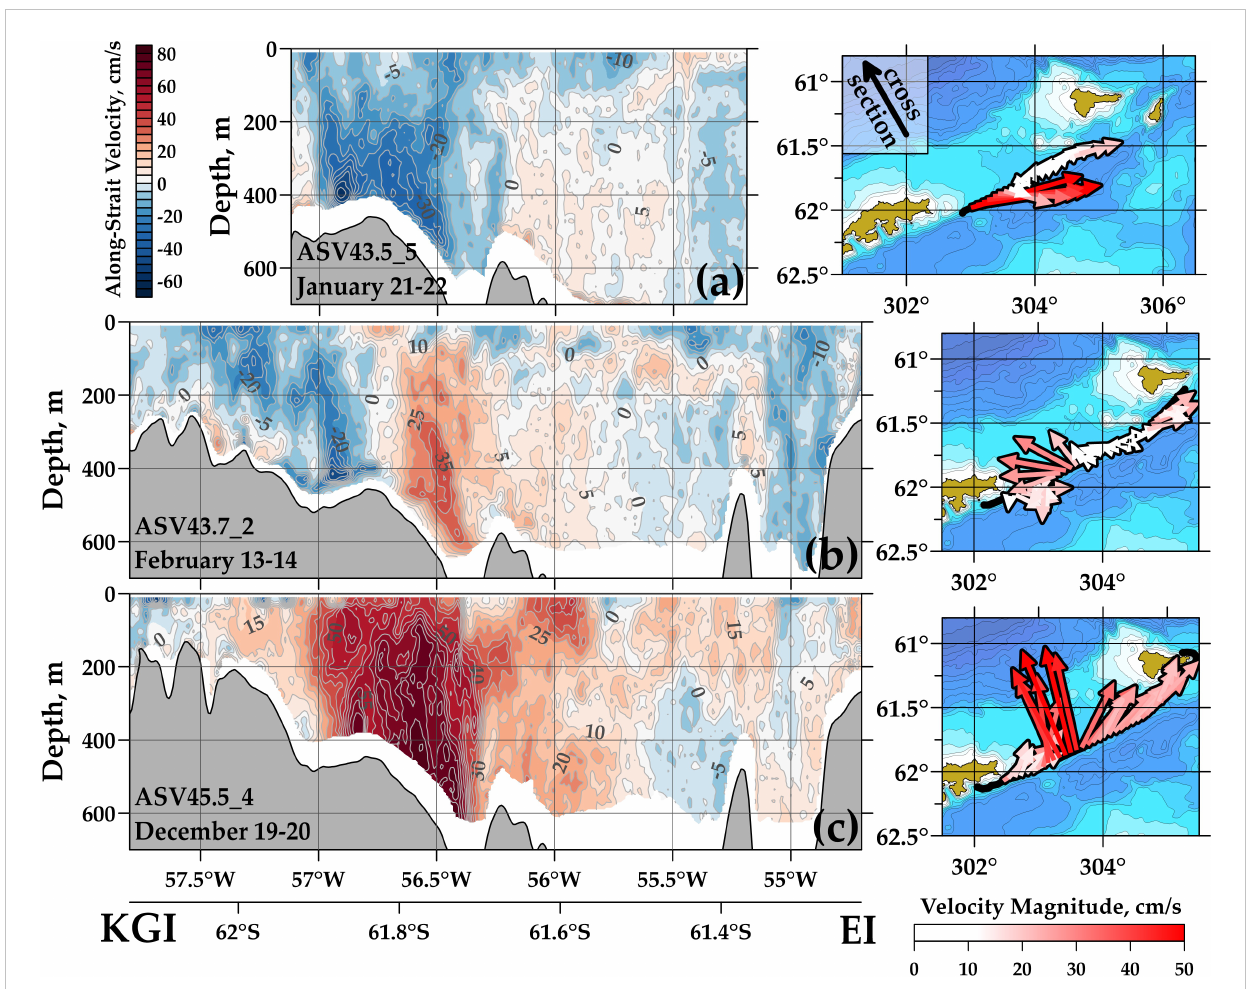
FIGURE 10 Cross-section velocity distributions at three crossings between King George Island (KGI) and Elephant Island (EI) performed on January 21-22 (A) , February 13-14 (B) , and December 19-20 (C) , 2017. The measurements were carried out from the R/V ASV. Positive velocities correspond to the north- north-west direction (the exact value is 330° relative to the north; this direction is shown by black arrow in the upper right panel). The velocities were projected to the direction along the strait independently on the orientation of transects. Locations of the crossings are shown in the right panels together with the depth-averaged SADCP velocities. The ocean bottom is shown by grey color. KGI, King George Island; EI, Elephant